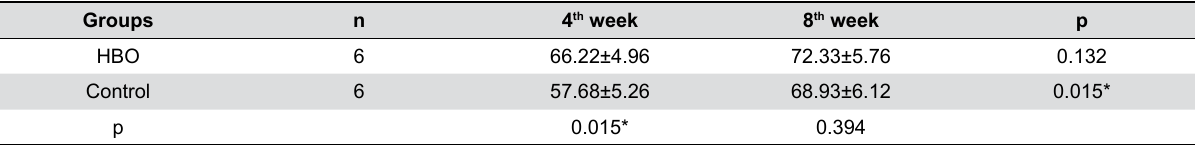
Table 2- Comparison of BIC (%) values between groups and according to different healing time points. Data is displayed as